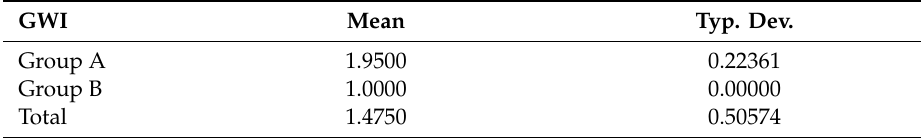
Table 19. E ff ect of the learning group in the General Wellbeing